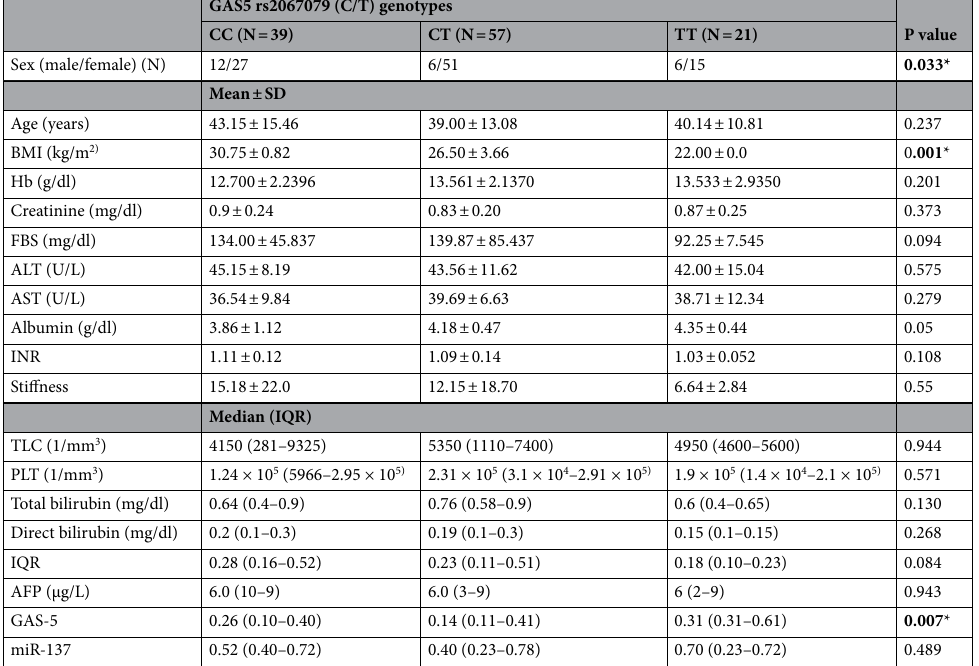
Table 3. Effect of GAS5 rs2067079 (C/T) on demographic, clinical and laboratory variables of chronic viral hepatitis B patients. BMI body mass index, GAS-5 lncRNA growth arrest-specific 5, miR-137 microRNA 137, AFP alpha fetoprotein, FBS fasting blood sugar, IQR interquartile range, SD standard deviation, Hb hemoglobin, TLC total leucocytic count, PLT platelet count, INR the international normalized ratio, kPa kilopascals, ALT alanine aminotransferase, AST aspartate aminotransferase.